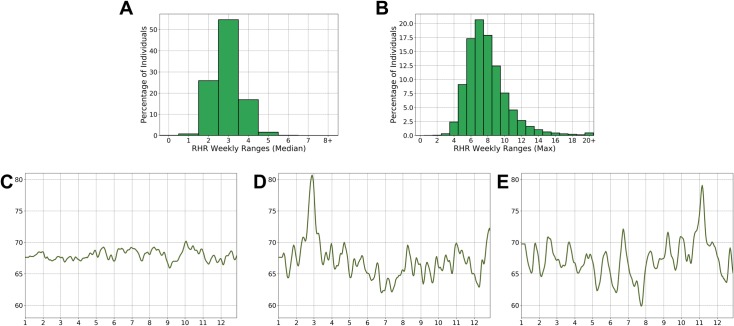
Distribution of the median (A) and maximum (Max) (B) difference in the resting heart rate (RHR) within 1 week and examples of longitudinal RHR variations in three women (C, D, E) over 1 year. For each individual, the median (A) and the maximum difference (B) in RHR over a week has been calculated considering all weeks with at least four RHR measurements. In the longitudinal examples, (C) shows a stable RHR for a woman over age 60 years; (D) a single episode of increased RHR in a woman between 50 and 60 years old; and (E) recurring monthly variability in a woman of childbearing age.